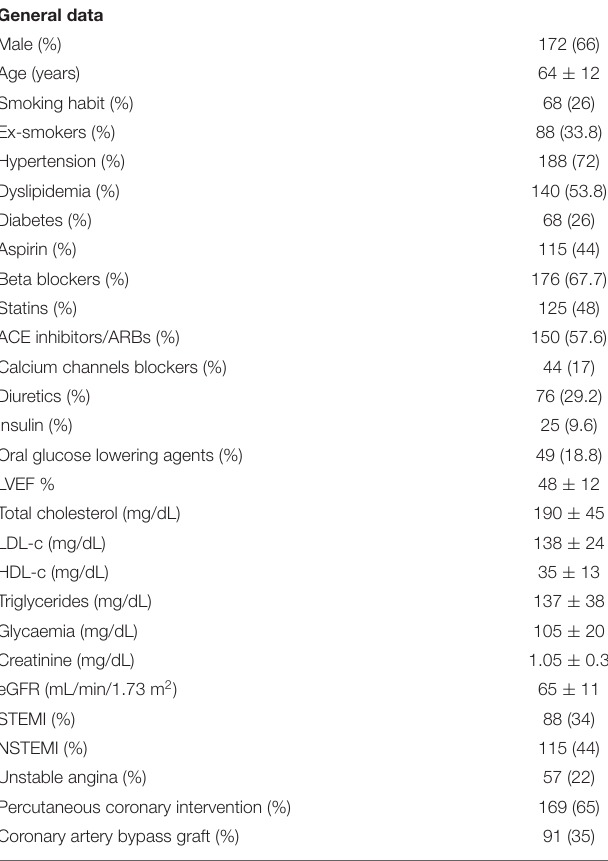
TABLE 1 | General characteristics of the study sample ( n = 260 patients). General